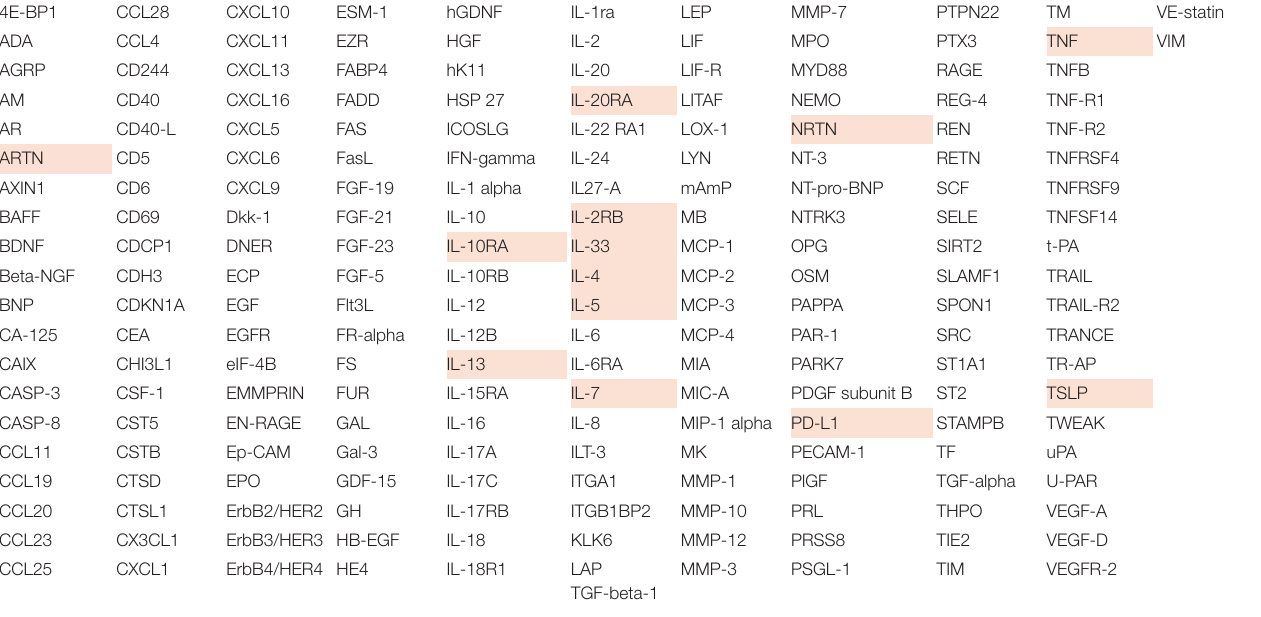
* The 13 biomarkers excluded due to analytical error are